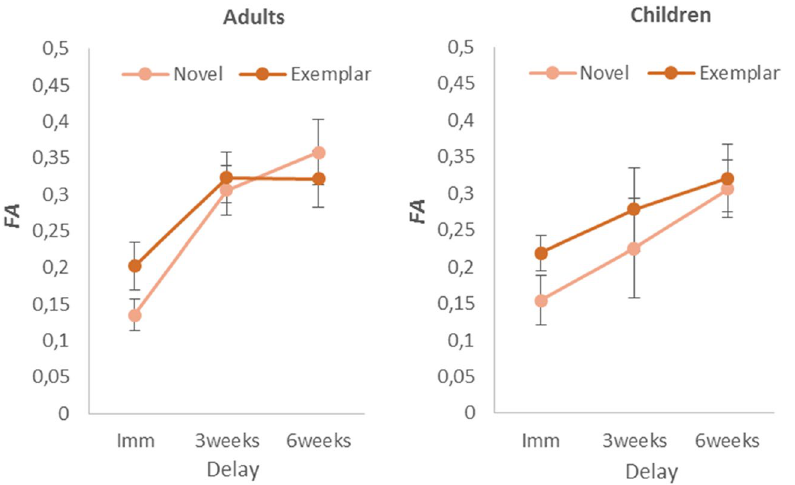
Figure 4. False alarms rates in the meaningful conditions “Novel” and “Exemplar” depending on the delay, for both adults (panel on the left) and children (panel on the right). The error bars show the standard error of the mean (n =